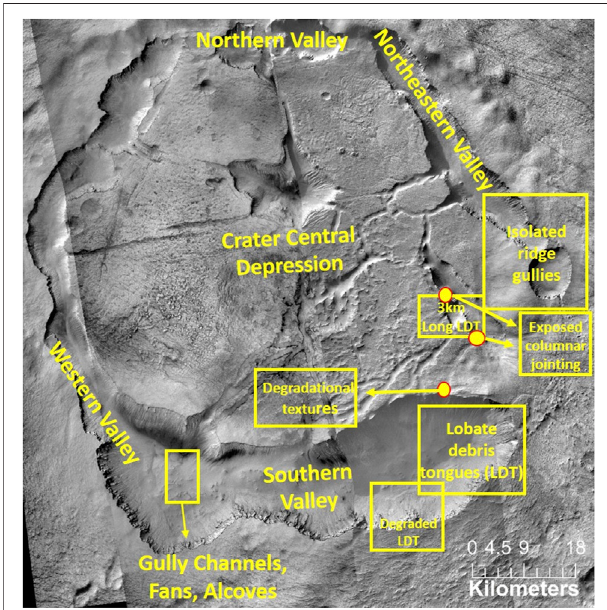
FIGURE 8 | Geological setting of Asimov crater, showing names of valleys and morphological parameters within Asimov crater. The background image is a mosaic image of CTX (having ID D08_030239_1326_XN_47S355W, D12_032019_1327_XN_47S354W, F09_039140_1327_XN_47S354W, F10_039694_1325_XN_47S355W, and